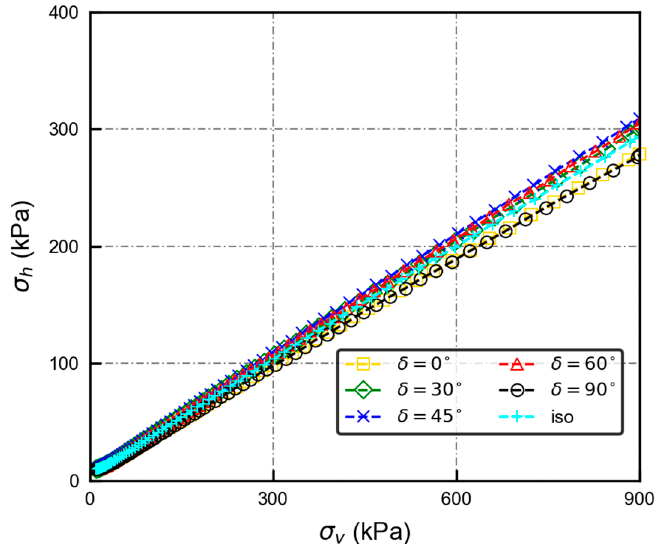
Figure 6. Stress path of K 0 -loading on specimens with different initial